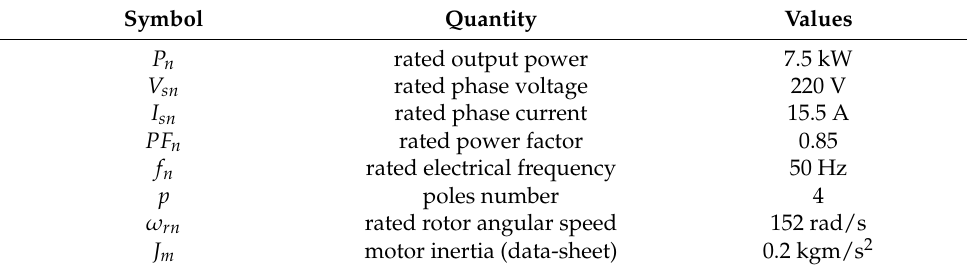
Table 1. Data from the motor nameplate and